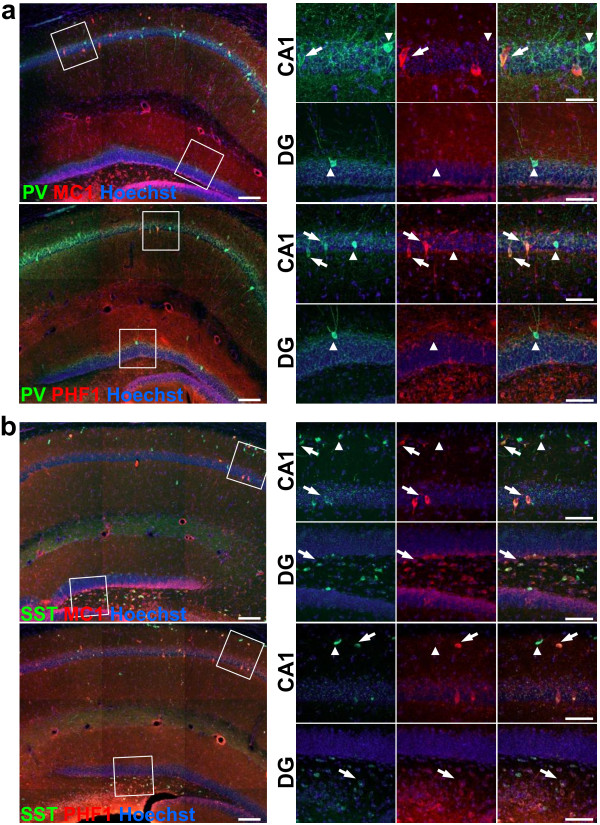
Colocalization of pathological tau, visualized with MC1 and PHF1 antibodies, in GABAergic interneurons in the hippocampus of aged JNPL3 (BL6) mice. (a) Fluorescent immunostaining against parvalbumin (PV) and MC1 or PHF1 counterstained with Hoechst shows that PV-positive GABAergic interneurons in the CA1 region express pathological tau. Higher magnification shows that not all neurons express pathological-tau. (b) Immunostaining against somatostatin (SST) also shows colocalization with pathological tau with SST-positive GABAergic interneurons. Interestingly, SST strongly colocalizes with pathological-tau in the hilus within the dentate gyrus (left panel; scale bar = 100 μm, right panel; scale bar = 50 μm; arrows show GABAergic interneurons that co-localize with pathological tau markers, while arrowheads show GABAergic interneurons that are not co-localizing with pathological tau markers).